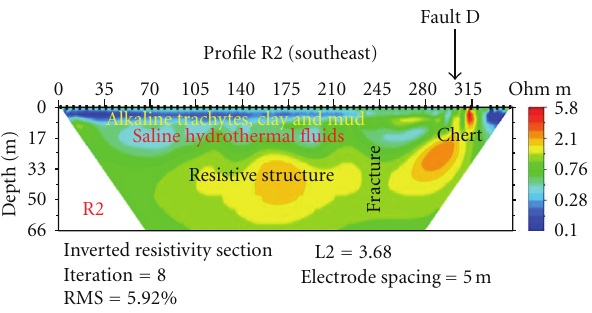
Figure 7: Inverted 2D resistivity section for profile 2. The profile crosses fault D almost perpendicular to its strike direction.